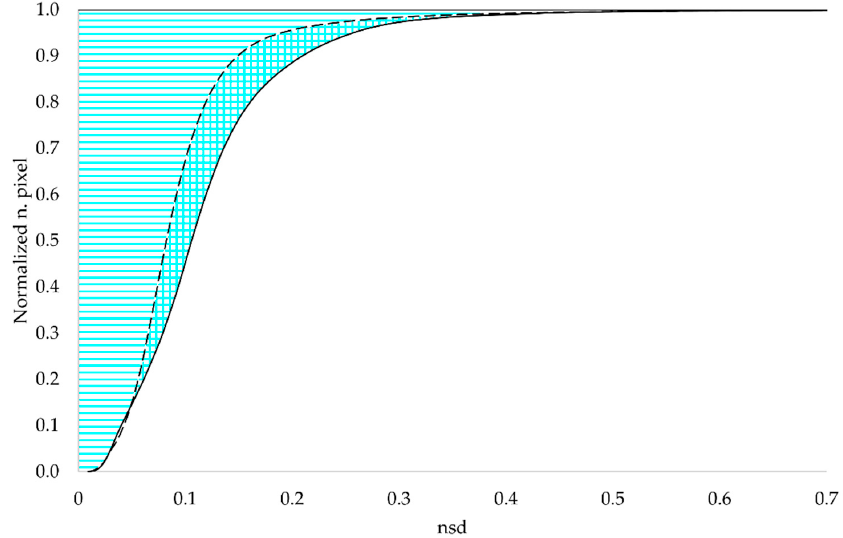
Figure 12. Nsd cumulative distribution before (solid line) and after (dashed line) the inclusion of topographic correction.